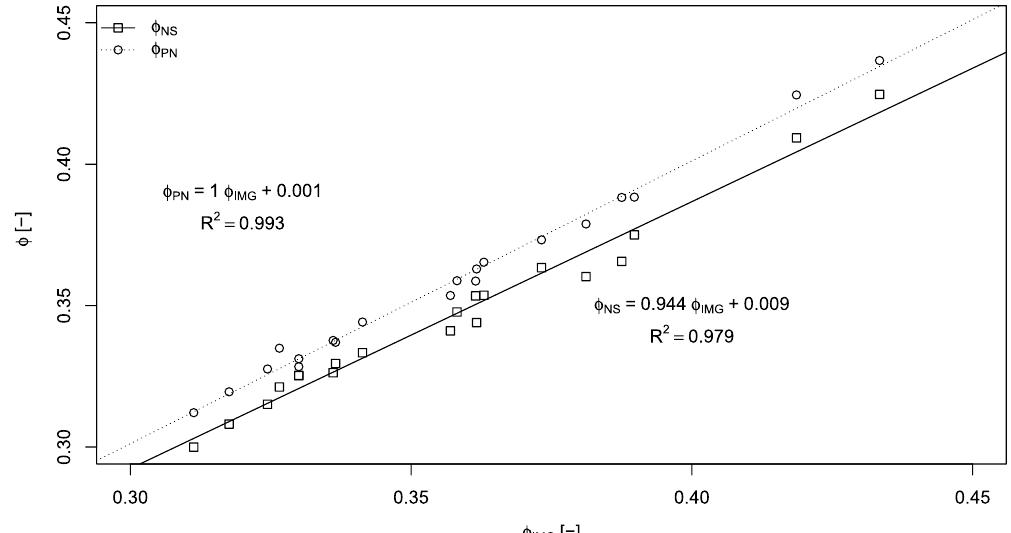
Figure 1. Total porosities of generated numerical meshes used for NS modeling (Φ NS ) and pore networks (Φ PN ) used for PN modeling as a function of the total porosity determined from CT imagery (Φ IMG ) (figure created using RStudio 1.3 software https ://rstud